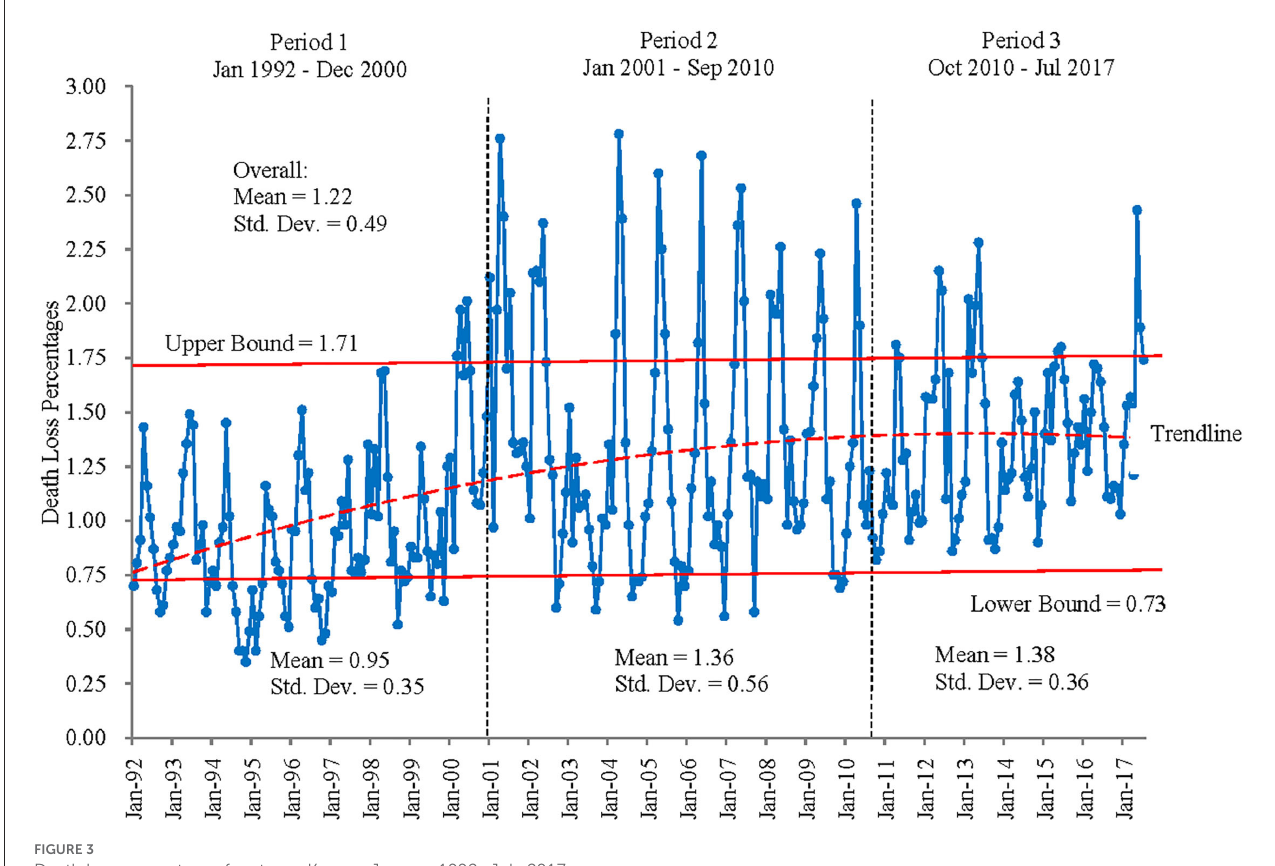
FIGURE3 Death loss percentages for steers, Kansas, January 1992–July 2017.